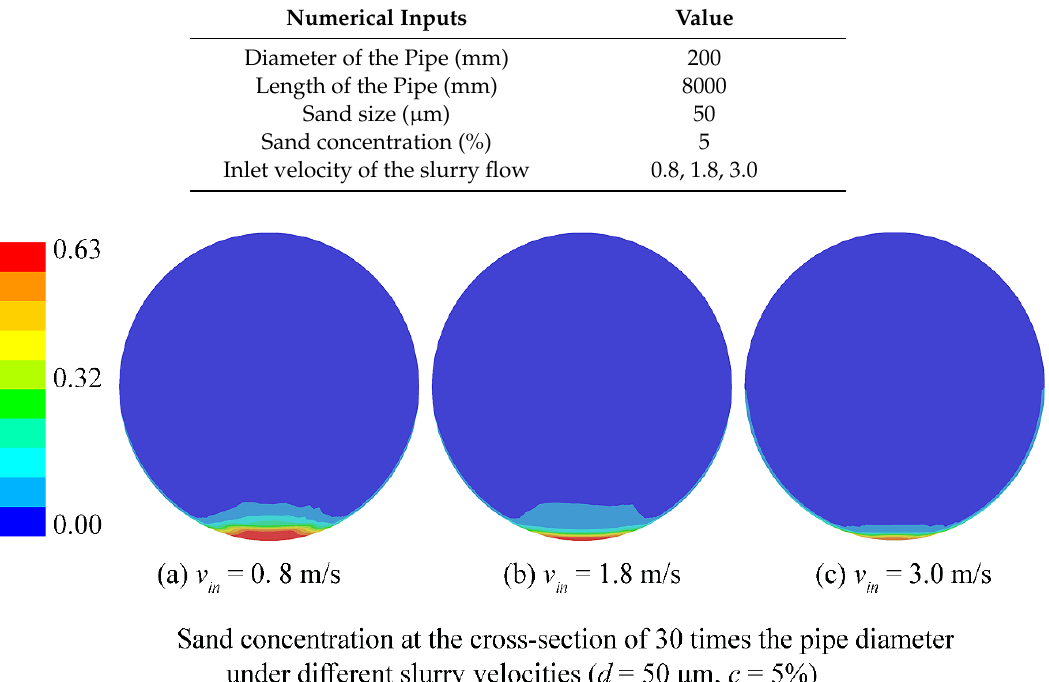
Figure 8. Sand concentration contours at the cross-section of 30 times the pipe diameter under the condition of different inlet slurry velocities ( d = 50 μm, c = 5%).